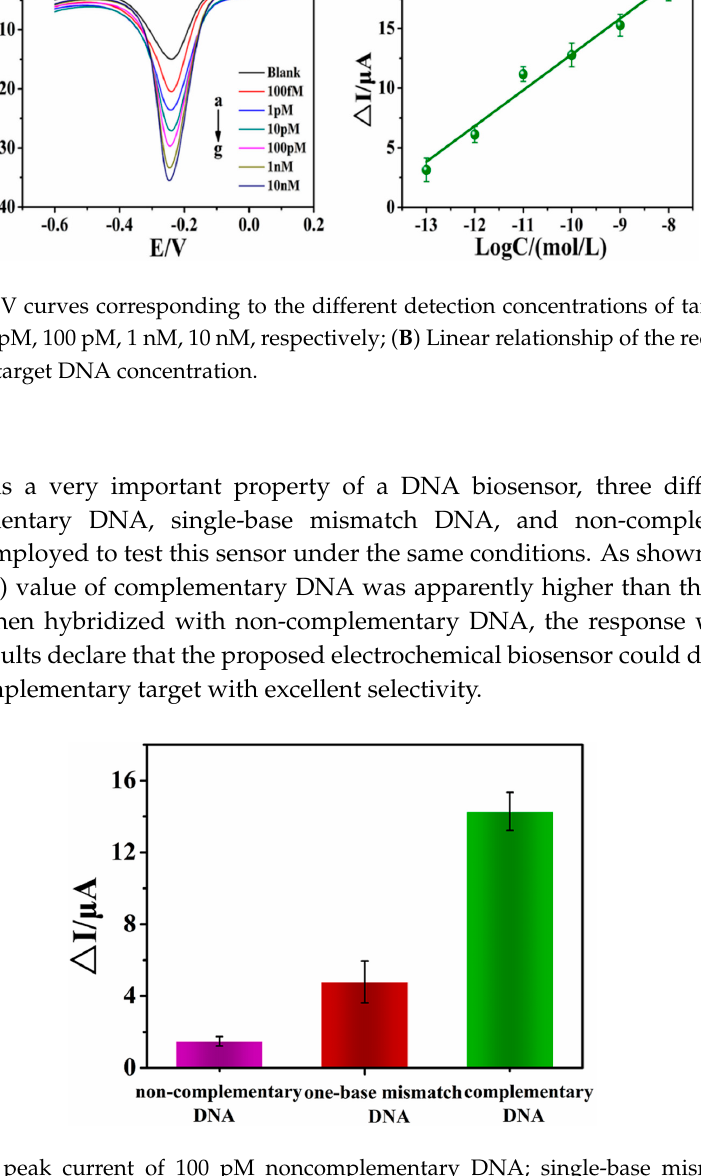
Figure 4. DPV peak current of 100 pM noncomplementary DNA; single-base mismatch DNA; complementary DNA.